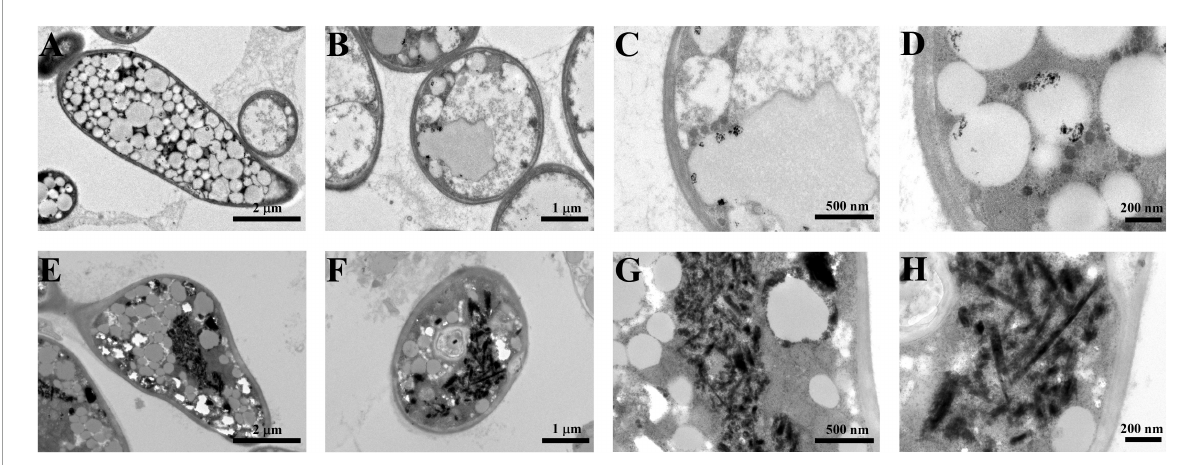
FIGURE3 Bio-TeNPs observation in the cells of strain AB1. Strain AB1 was incubated with 0 mmol/L Te(IV) (A–D) and 0.5 mmol/L Te(IV) (E–H) , respectively. Then, the cells were collected to prepare ultrathin sections and observed under